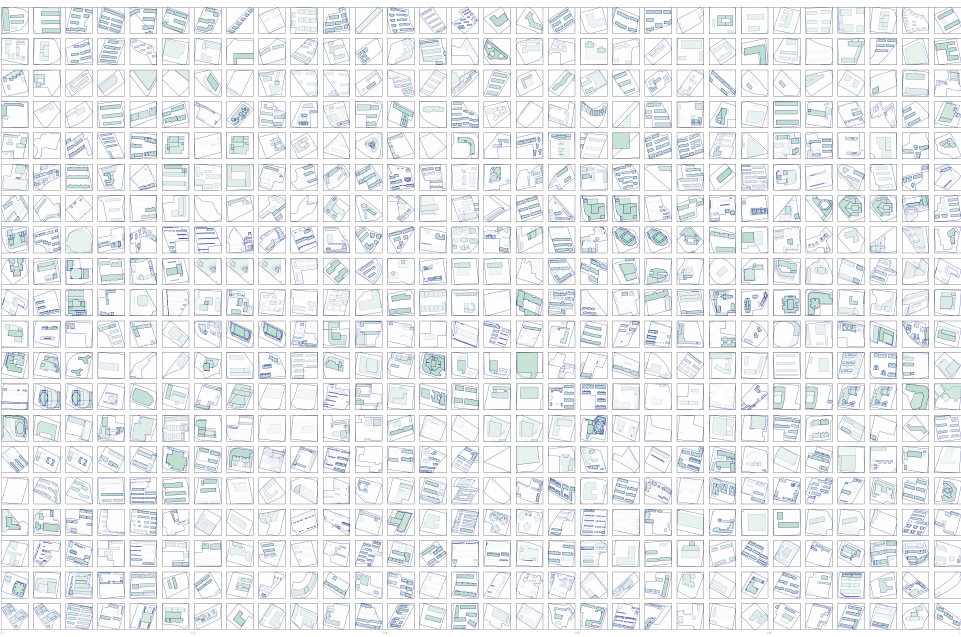
Figure 1. Visualization of map data including the area of interest, building footprints, and road networks.